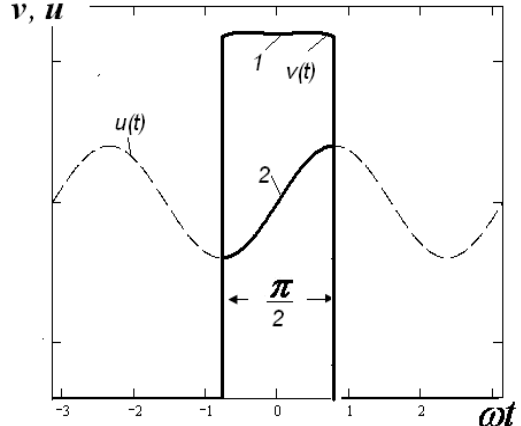
Figure 21. Scheme for bunching of an FS-bunch with a second harmonic cavity detuned to the right: (1) monospeed bunch, (2) microwave voltage in the cavity of the second harmonic . As for the gain factor, the rating (Equation (15)) applies for it in the mode of full electronic load compensation. Since the ratio is at least 10 in the grid design, the gain factor should be at least 30 dB even for small gain factors.